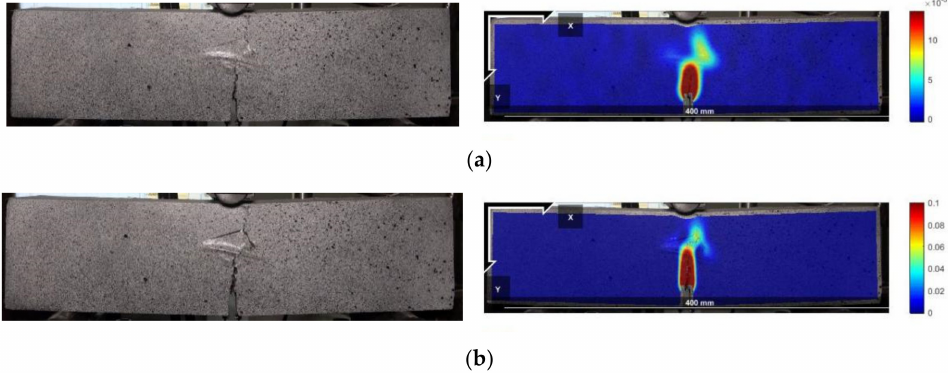
Figure 6. Failure process (left) and DIC strain field (right) of the H 6 S 6 specimen. ( a ) Peak value; ( b ) CMOD = 3.5 mm.